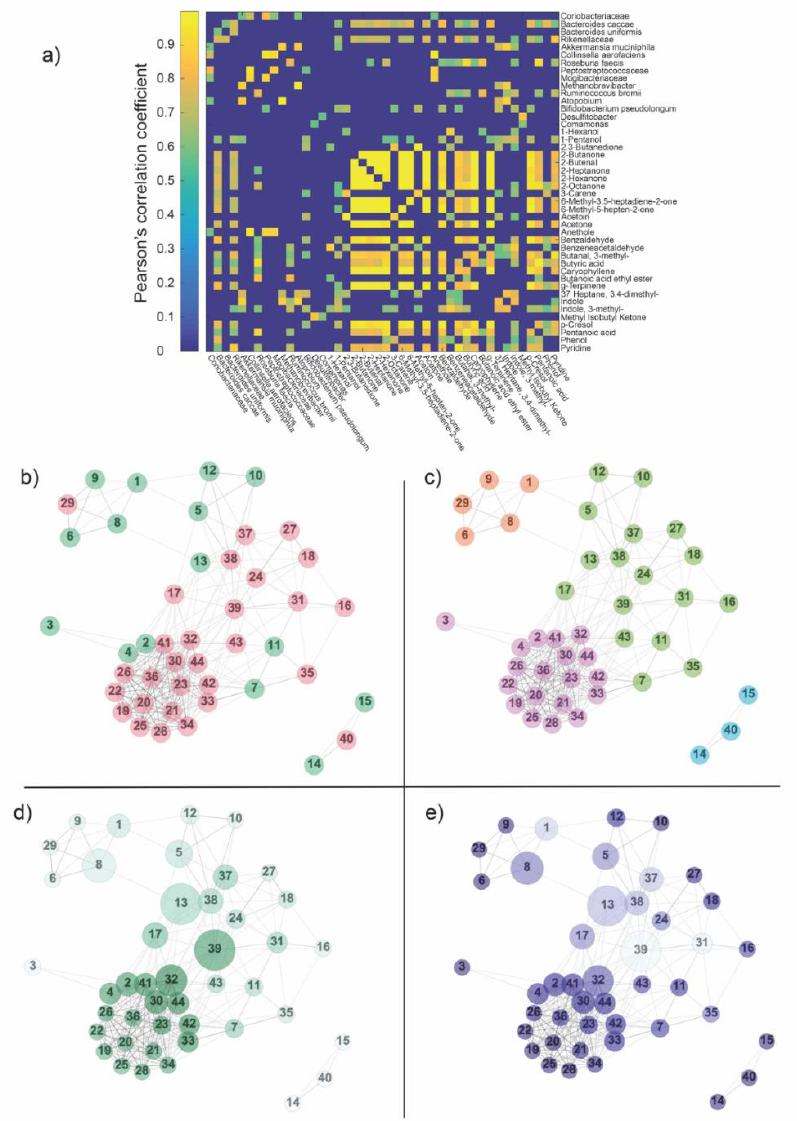
Figure 3. ( a ) The matrix obtained by cross-correlating OTUs and metabolites across subjects was thresholded according to statistical significance ( p < 0.05) and False Discovery Rate (FDR)-corrected for multiple comparisons. Only positive correlations were found to be statistically significant and subsequently associated with the edges, giving place to the weighted adjacency matrix, i.e., the network. ( b ) The distribution of features within the network: green—OTUs, pink—metabolites. Numbers within the nodes identify features according to the order shown aside the weighted adjacency matrix. The network was divided into two main components: a big one and a triplet (nodes 14, 15, 40). ( c ) Communities founded by the Louvain algorithm in the network. Colors were used only for distinguishing the different communities, which, in turn, represents the affinity of species according to their covariance across subjects. ( d ) Degree and betweenness centrality calculated in the network. The size of each node is proportional to its betweenness, while the color code (from white to dark green) refers to the magnitude of the degree centrality (from low degree to high degree). ( e ) Clustering coefficient and betweenness centrality calculated in the network. The size of each node is proportional to its betweenness centrality, while the color code (from white to dark blue) refers to the magnitude of the clustering coefficient (from low clustering to high clustering coefficient). Legend Panel b–e. (1) Coriobacteriaceae; (2) Bacteroides caccae ; (3) Bacteroides uniformis ; (4) Rikenellaceae; (5) Akkermansia muciniphila ; (6) Collinsella aerofaciens ; (7) Roseburia faecis ; (8) Peptostreptococcaceae; (9) Mogibacteriaceae; (10) Methanobrevibacter ; (11) Ruminococcus bromii ; (12) Atopobium ; (13) Bifidobacterium pseudolongum ; (14) Desulfitobacter ; (15) Comamonas ; (16) 1-Hexanol; (17) 1-Pentanol; (18)